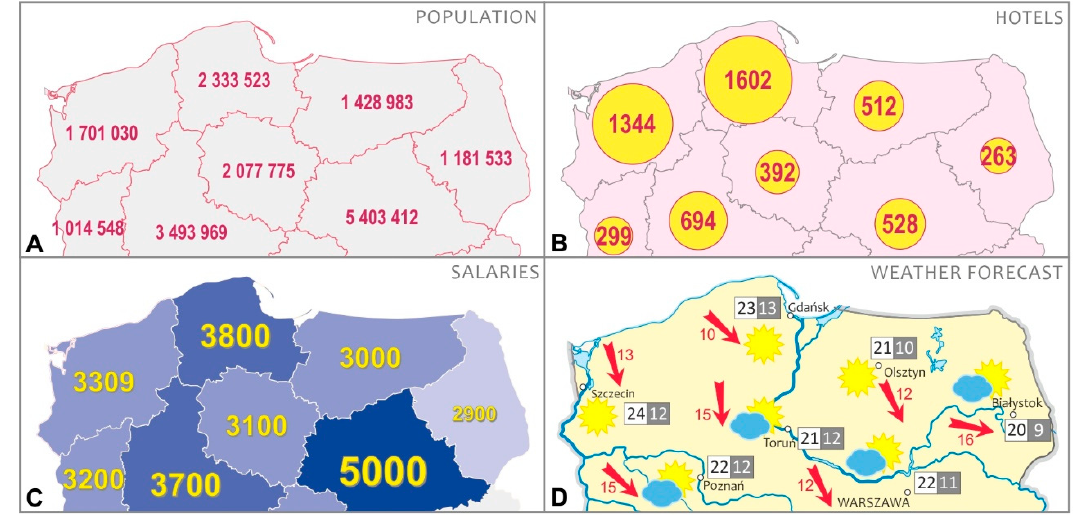
Figure 1. Examples of the use of numbers on small-scale thematic maps: ( A ) even-sized numbers on a map showing the values of a given phenomenon (single-variable), ( B ) even-sized numbers with proportional symbols (content redundancy), ( C ) proportional numbers with a choropleth map (content redundancy), and ( D ) presentation of temperature and wind speed on a weather map (multi-variable map).